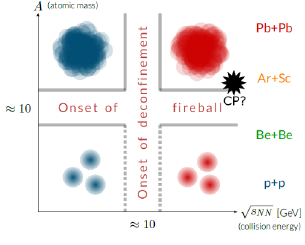
Figure 7. The four domains of hadron production defined by the onset of deconfinement and onset of